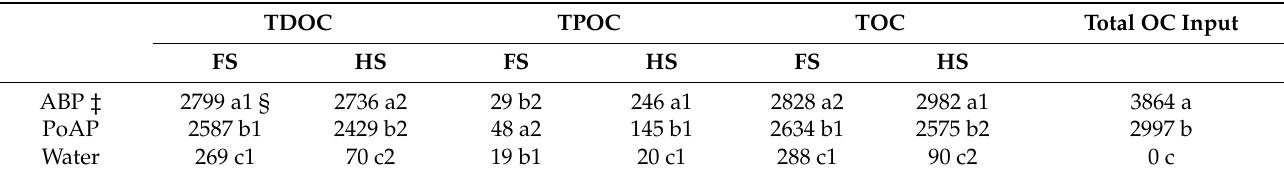
† Total dissolved and particulate organic carbon (TDOC and TPOC) was the sum of DOC and POC collected from all three applications cycles, respectively for hydrophobic or fresh sand system. Total organic carbon (TOC) was calculated by summing the TDOC and TPOC for each treatment. ‡ ABP, alkyl block polymer; PoAP, polyoxyalkylene polymer. Data from water treatment only included one application and sequential washes as water failed to infiltrate into hydrophobic sands beyond the first application. § Means in the same column of hydrophobic or fresh sand system followed by the same letters were not significantly different based on Fisher’s Protected LSD at p < 0.05; means in the same row followed by the same numbers were not significantly different based on Fisher’s Protected LSD at p < 0.05. Total organic carbon (OC) input is the combined input of three applications from both wetting